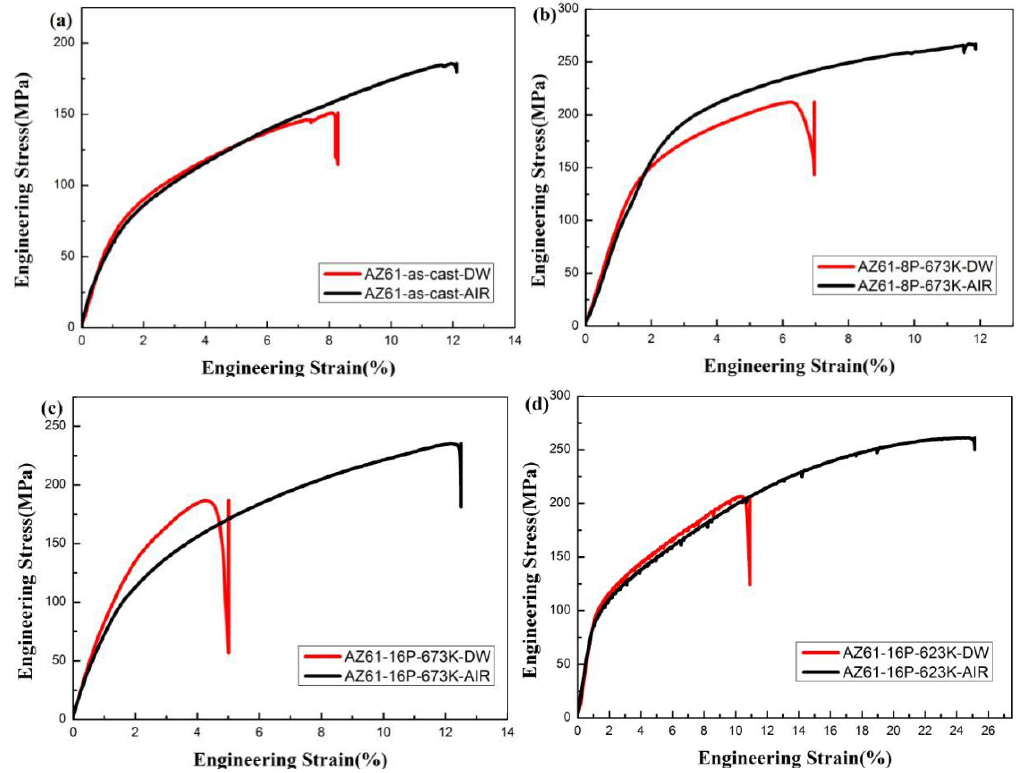
Figure 5. Typical SSRT curves of various of AZ61 Mg alloys tested in air and distilled water (DW) ( a ) 1#, ( b ) 2#, ( c ) 3# and ( d )